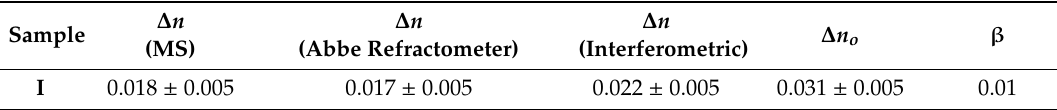
Table 2. The birefringence ∆ n by using the modified spectrophotometer (MS), Abbe refractometer and interferometric techniques at 589.3 nm and temperature of 65 ◦ C, ∆ n o is the birefringence at T = 0 ◦ C and the material constant β for the investigated